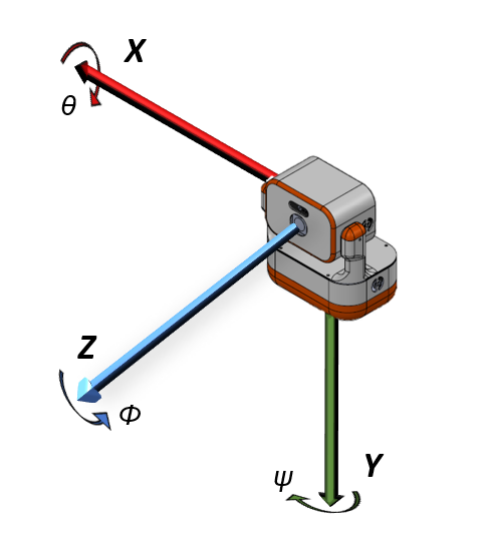
Figure 2. Robot’s diagram illustrating the axes and their respective rotation angles. Equation (1a) computes the rotation transformation from the LiDAR to the pan point of view (PPV) frames l R ppv ∈ SO 3 x 3 (the group of special orthogonal matrices), considering φ and θ as the current acquisition odometry. The point cloud captured by the LiDAR is C l